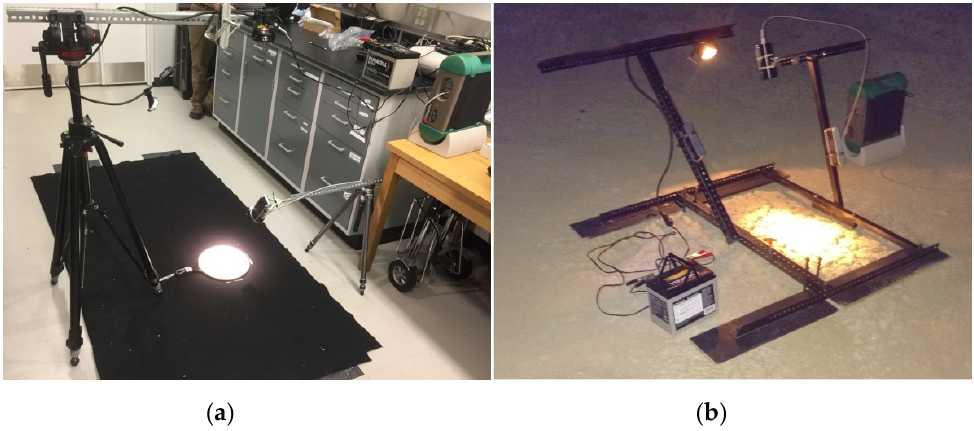
Figure 1. ( a ) Equipment setup for laboratory measurements. Portable ASD spectrometer and Lowel halogen photographic light source are mounted on tripods with swing arms. ( b ) Field measurements using same source and sensor as used in laboratory measurements. Angles are measured by digital protractor mounted on swing arms in both